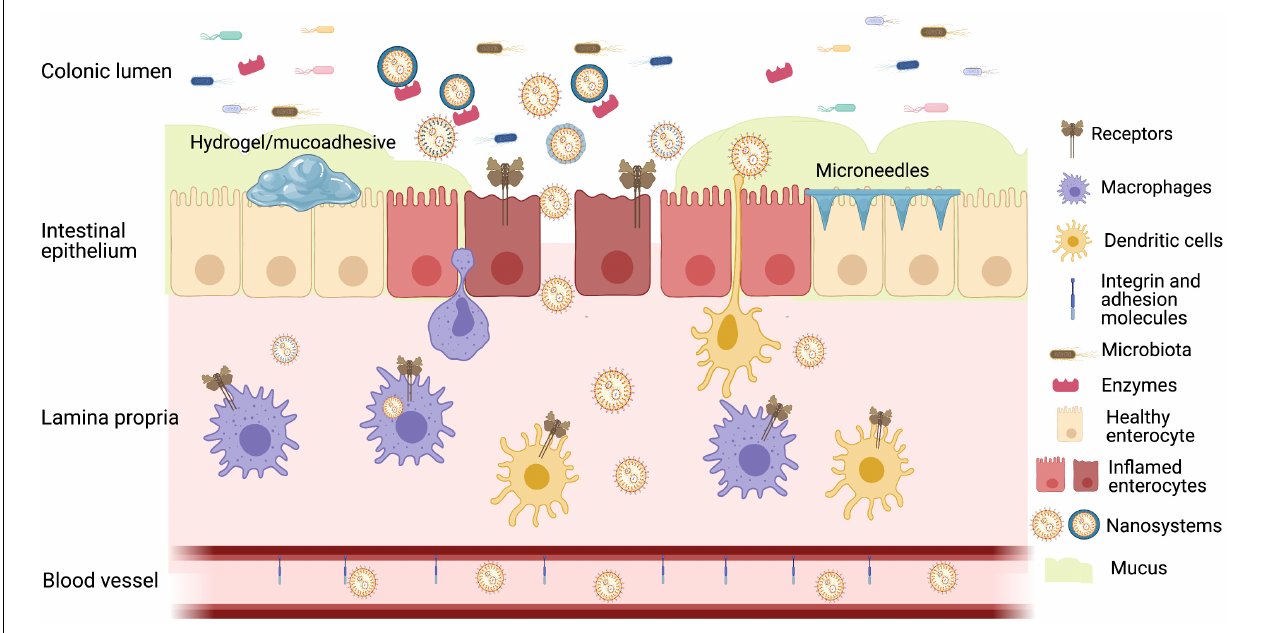
FIGURE 1 | Representative image of oral strategies for colon drug delivery based on inflamed mucosa presenting decreased diversity in microbiota, overexpression of receptors, enzymes, and redox substances, increased permeability, activation of immune system, and decreased mucus barrier. Created with